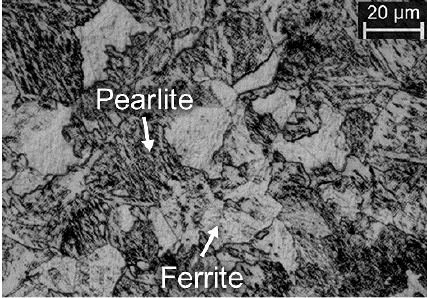
Figure 1. Optical micrograph of the AISI 4140 steel microstructure consisting of ferrite and pearlite constituents.